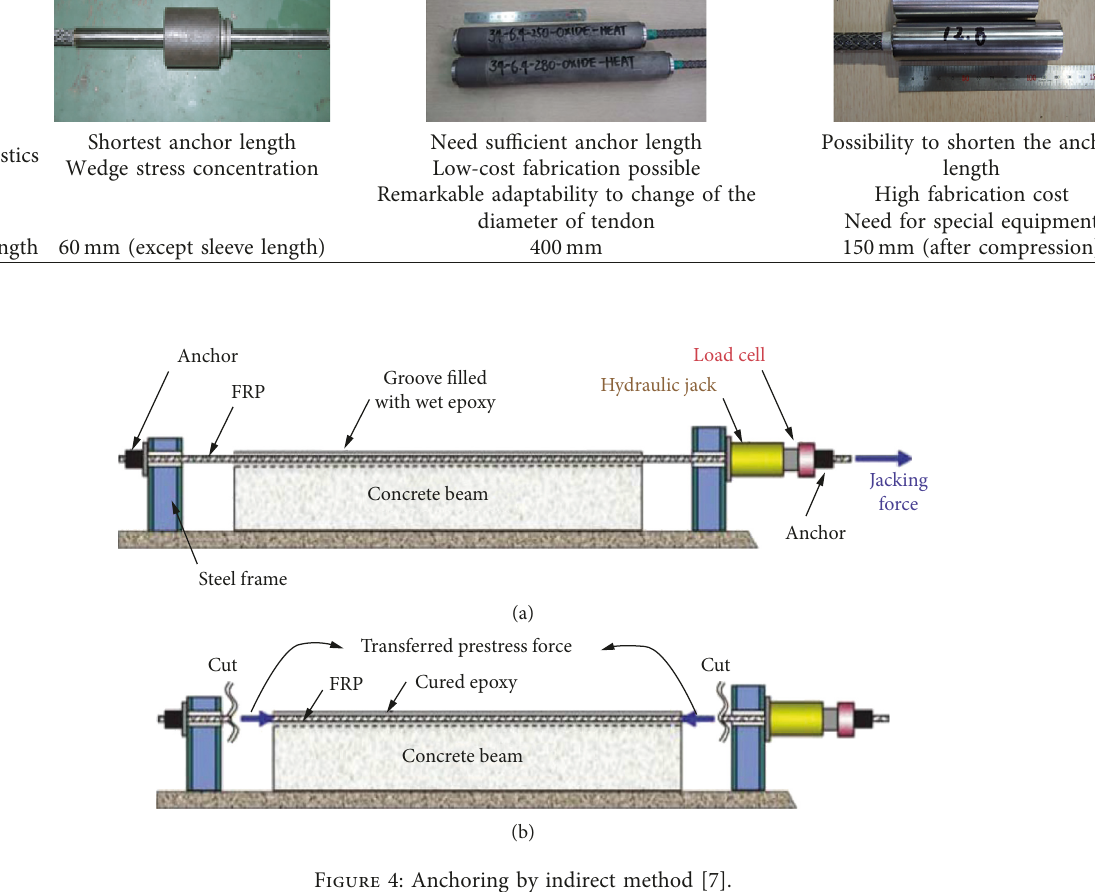
Figure 4: Anchoring by indirect method [7].